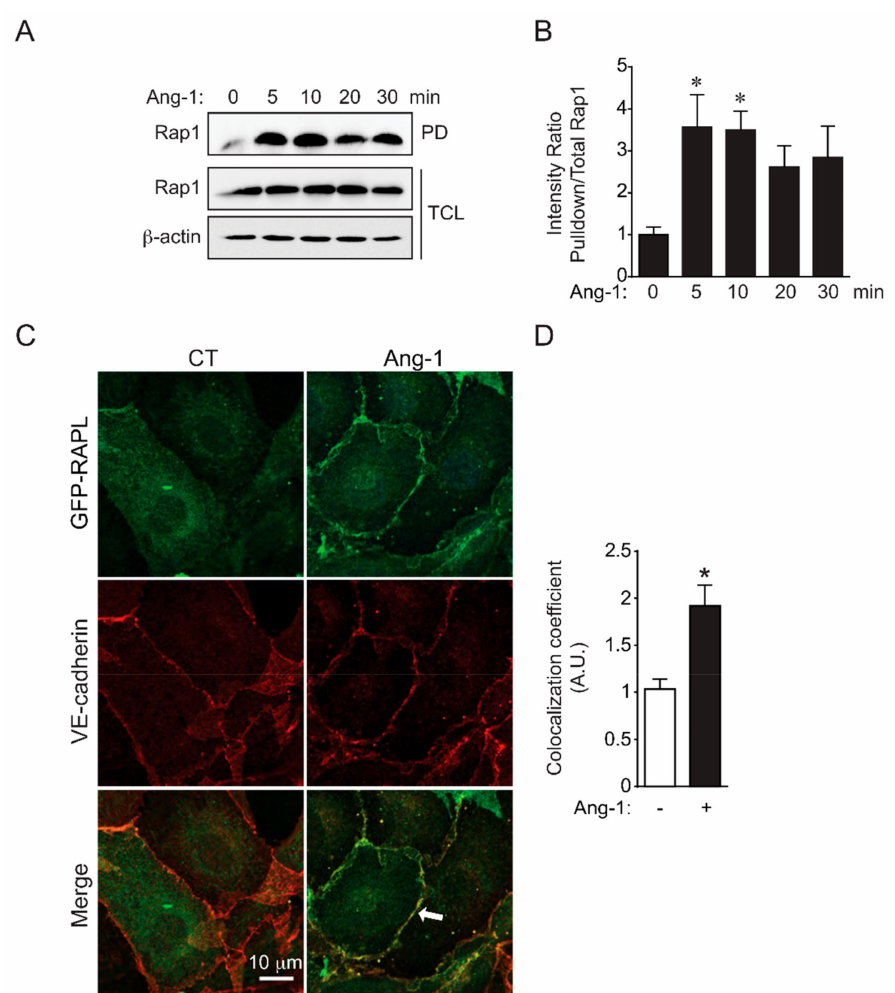
Figure 1. Ang-1 activates Rap1 and induces RAPL accumulation at cell–cell junctions. ( A ) Rap1 activation determined by pull-down assays using RalGDS Rap-binding domain (RalGDS-RBD / GST). Bovine aortic endothelial cells (BAECs) were treated with Ang-1 (100 ng / mL) for the indicated times, and pull-down (PD) assay were performed on protein extracts to reveal the amount of active Rap1 (Rap1-GTP) in comparison to the Rap1 amount in total cell lysates (TCL). β -actin was used as